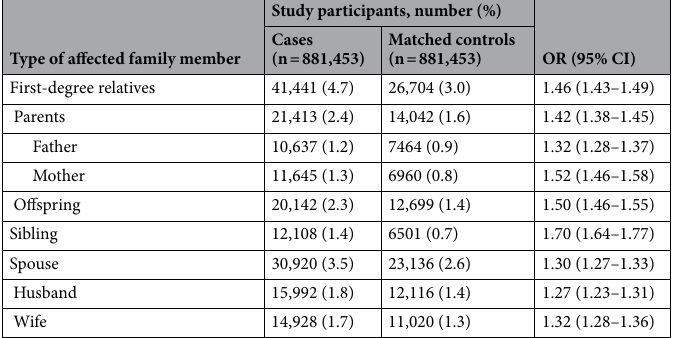
Table 2. Association between familial aggregation of CKD and risk of CKD. All models were adjusted for age, sex, residential area, income level, and comorbidities such as hypertension, diabetes, ischemic heart disease, cerebrovascular disease, and dyslipidemia. CKD chronic kidney disease, OR odds ratio, CI confidence interval.